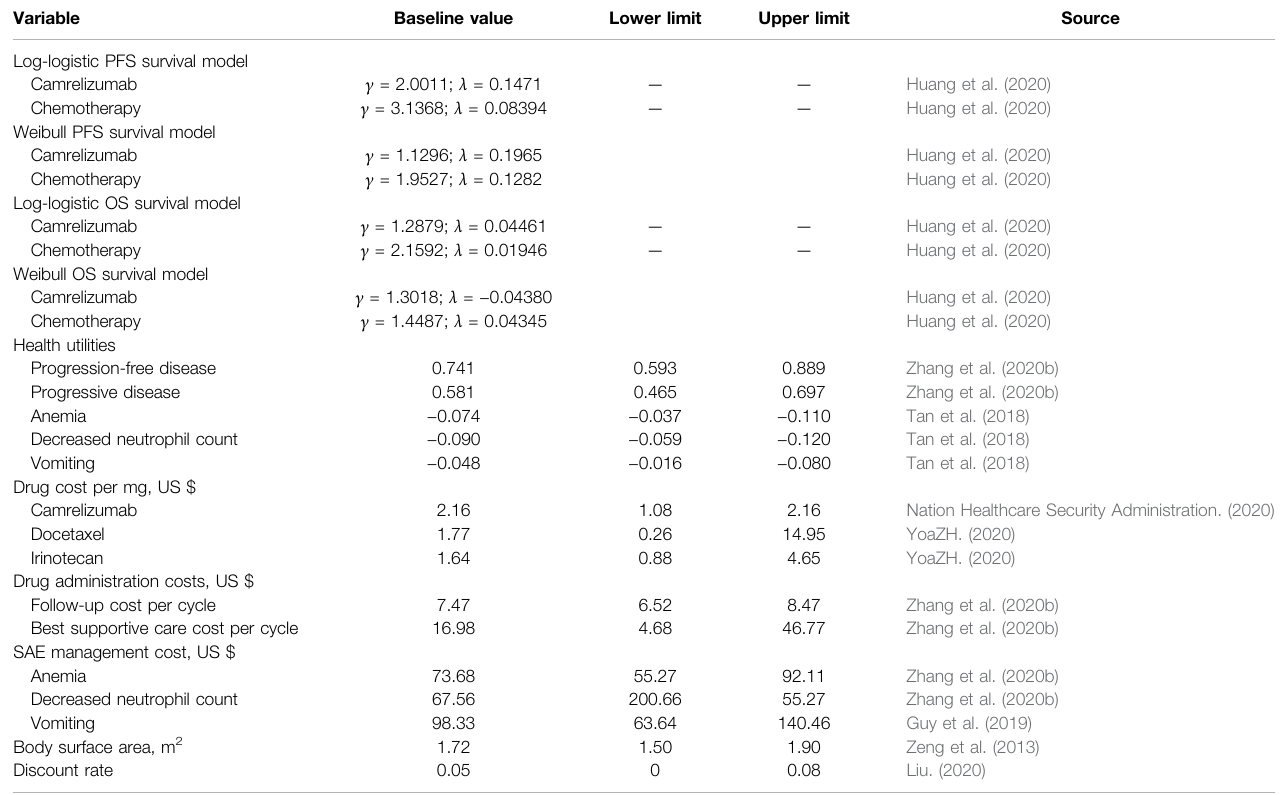
TABLE 1 | Basic parameters input to the model and the ranges of the sensitivity